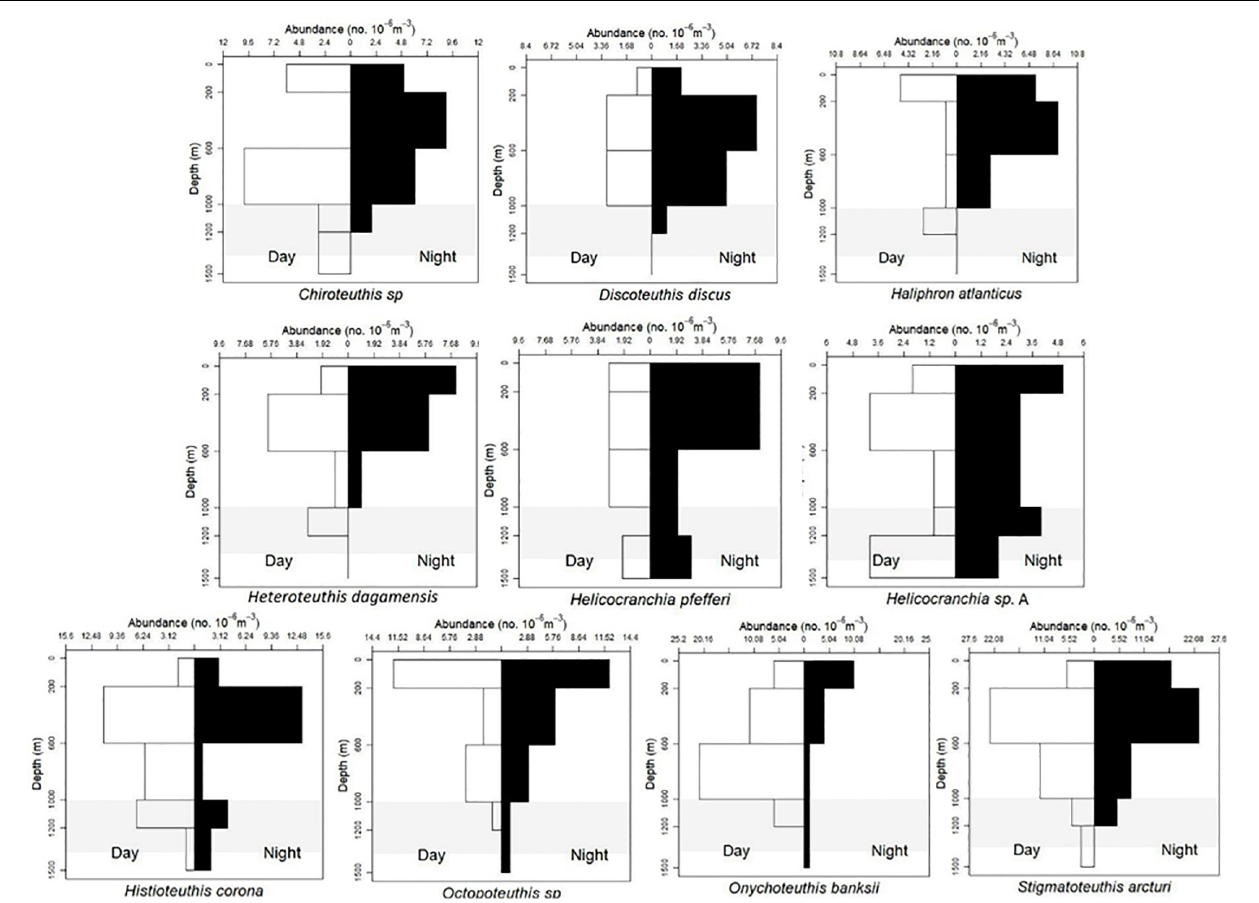
FIGURE 5 | Vertical distribution patterns of 10 cephalopods. Mesopelagic asynchronous migrators as described by T. Sutton et al. (unpublished). Chiroteuthis sp., n = 42; Discoteuthis sp., n = 22; H. atlanticus , n = 29; H. dagamensis , n = 27; Helicocranchia sp. A, n = 31; H. pfefferi , n = 32; H. corona , n = 50; O. banksii , n = 61; S. arcturi , n = 102; S. melancholicus , n = 20; Cycloteuthis sirventi , n = 18; Sthenoteuthis pteropus , n = 18; Octopoteuthis sp., n = 40; shaded region indicates the deep oil plume